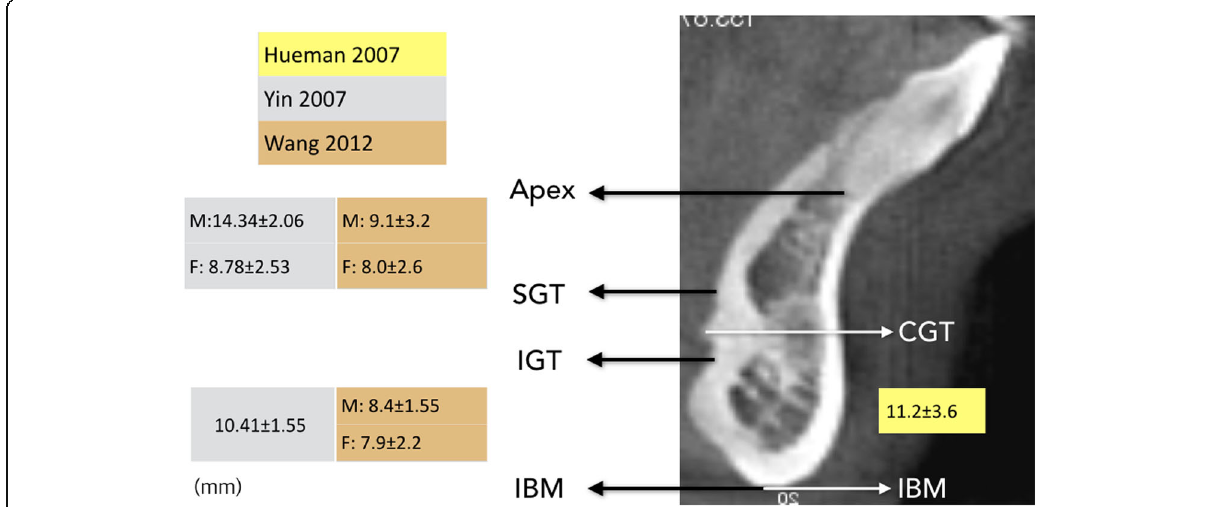
Fig. 1 Position of the genial tubercle evaluated by radiographic measures